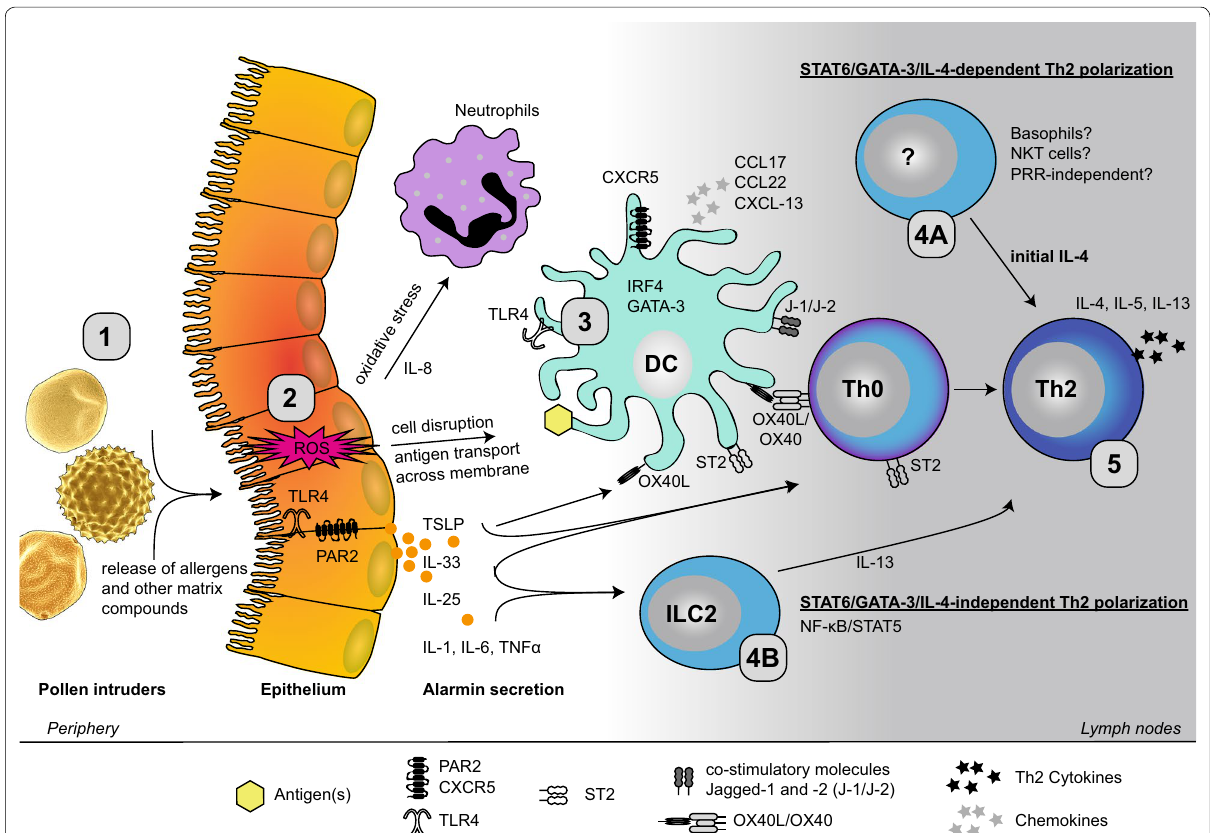
Fig. 1 Pollen‑induced activation of the innate immune system and Th2 polarization. The initiation of allergic sensitization is a complex network of diverse immune cells, such as DCs, ILC2s and neutrophils. Upon encounter with the epithelium the pollen hydrates and releases its content including allergens and various other bioactive molecules (1). At the epithelium (2), this immunogenic cocktail causes the disruption of the epithelial membrane, activates PRRs such as TLR4 and PAR2, triggers the release of alarmins (TSLP, IL‑25 and IL‑33), and induces oxidative stress and secretion of IL‑8 and other pro‑inflammatory cytokines (IL‑1, IL‑6 and TNFα). In turn, DCs are activated (upregulation of surface markers including OX40L and notch ligands), migrate to the lymph nodes (expression of CXCR5), where they present processed antigens via MHC‑II to naïve T cells (3). Th2 polarization occurs either STAT6/GATA‑3/IL‑4‑dependent (4A) or ‑independent via the NF‑κB/STAT5 pathway and the contribution of ILC2s (4B). The origin of initial IL‑4 for Th2 polarization is still a matter of discussion; proposed candidate are basophils and NKT cells. Once a Th2 immune response has been initiated, a class‑switch of B cells to antigen‑specific IgE‑producing plasma cells occurs resulting in the sensitization of susceptible individuals to pollen allergens (5). CCL17, CCL22 chemokine (C–C motif) ligand 17 and 22, CCR7 C–C chemokine receptor type 7, CD80, CD86 and CD40 cluster of differentiation 80, 86 and 40, CXCL-13 C‑X‑C motif chemokine 13, CXCR5 C‑X‑C chemokine receptor type 5, DCs dendritic cells, GATA-3 GATA binding protein 3, IL- Interleukin, ILC2 type 2 innate lymphoid cells, IRF4 interferon regulatory factor 4, NF-κB nuclear factor ’kappa‑light‑chain‑enhancer’ of activated B cells, NKT natural killer T, OX40L OX40 ligand, PARs protease activated receptors, PRRs pattern recognition receptors, ROS reactive oxygen species, ST2 IL‑33 receptor, STAT5, STAT6 signal transducer and activator of transcription 5 and 6, Th T helper cells, TLR4 toll‑like receptor 4, TNFα Tumor necrosis factor alpha, TSLP thymic stromal